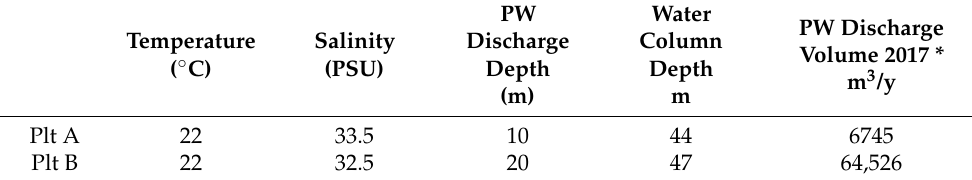
Table 1. PW discharge features in the year 2017 for platform A and